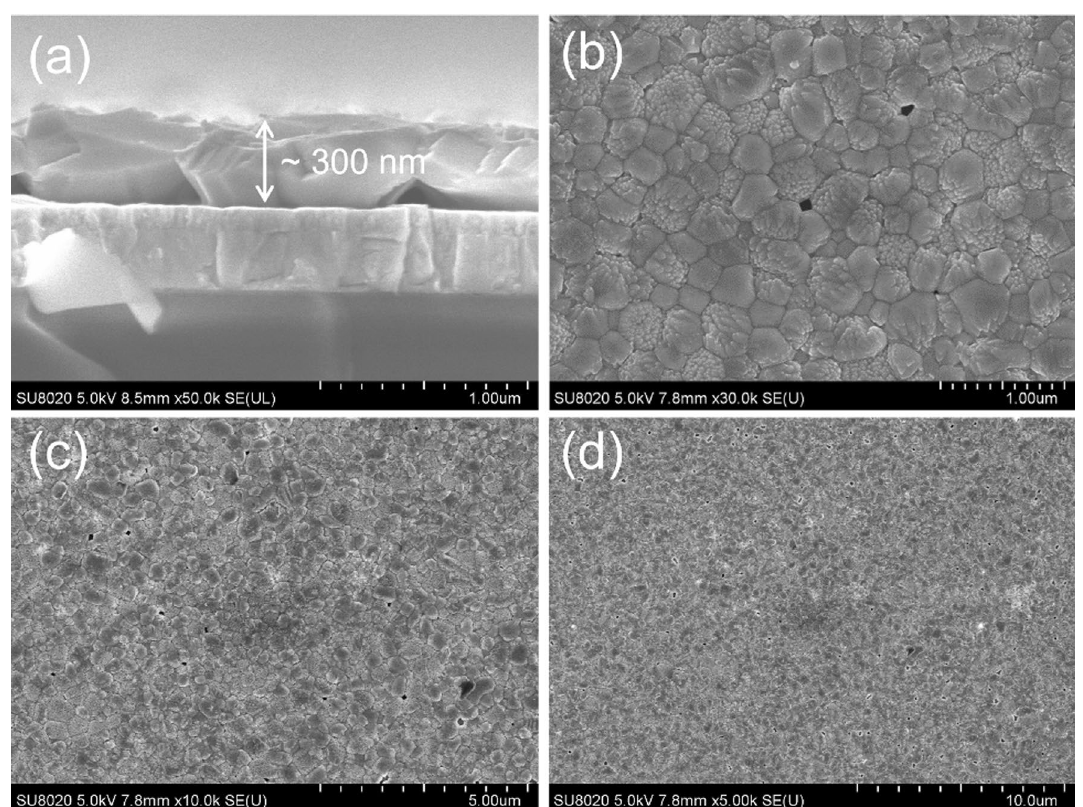
Fig. 4 SEM images of BiVO